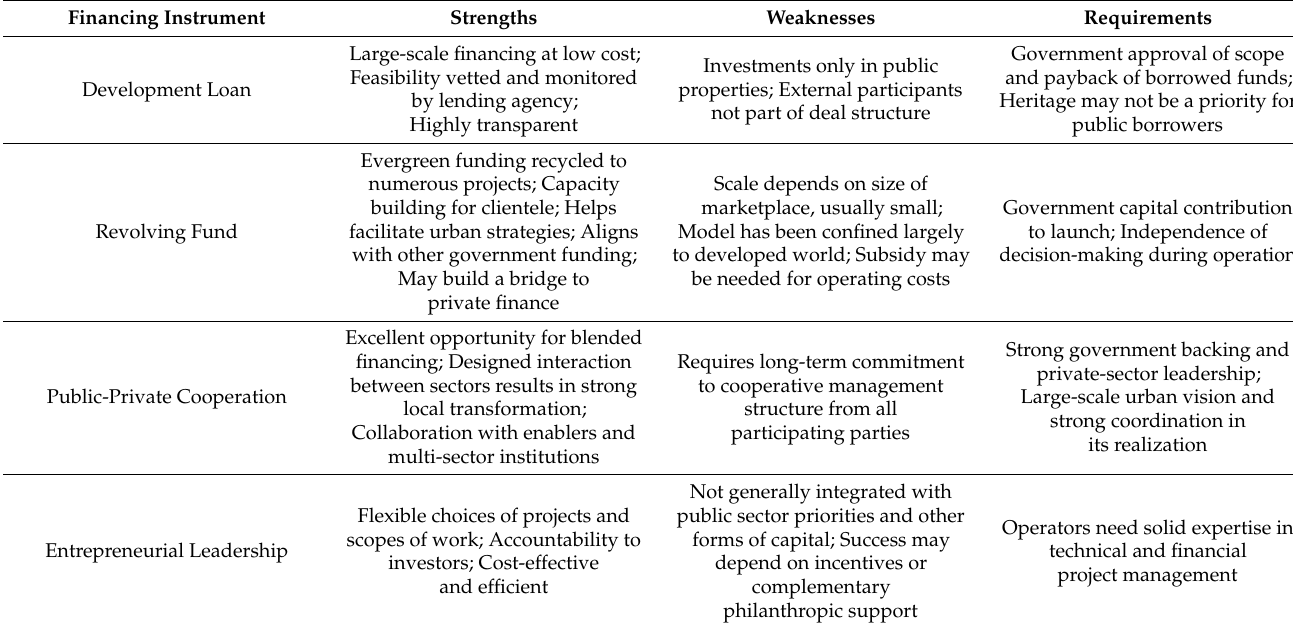
Table 1. Comparative advantages of different financing